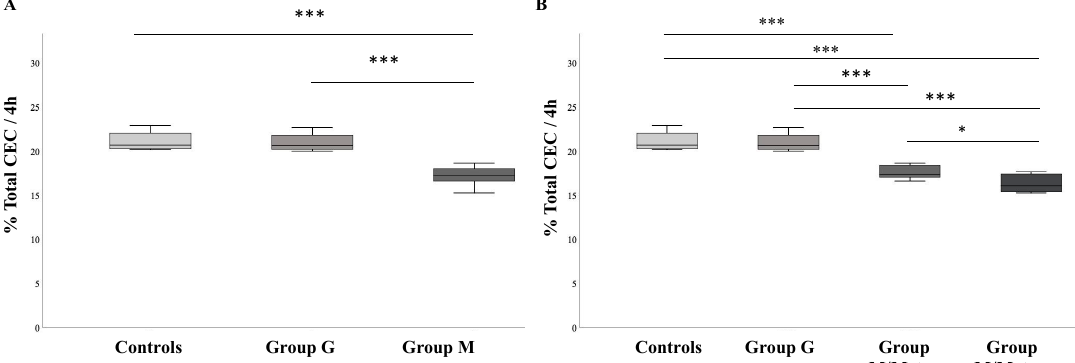
Figure 1. Whole HDL cholesterol efflux capacity according to NAFLD classification and presence of MetS. ( A ) shows differences in whole CEC according to NAFLD classification. In univariate analysis Group M had lower cholesterol efflux capacity independently from ApoAI levels and HFF% ( P adj < 0.001); ( B ) shows differences in whole CEC according to the presence of MetS. In univariate analysis Group M/MetS+ had lower CEC independently from age, ApoAI levels and HFF% ( P adj = 0.010) as compared to Group M/MetS − . Cholesterol efflux capacity expressed in relative efflux is presented in median and IQR. *** for p < 0.0001; * for p = 0.029. Group M, metabolic NAFLD group; Group G, genetic NAFLD group; Group M/MetS − , metabolic NAFLD group without MetS diagnosis; Group M/Mets+, metabolic NAFLD group with MetS diagnosis (see Section 2).